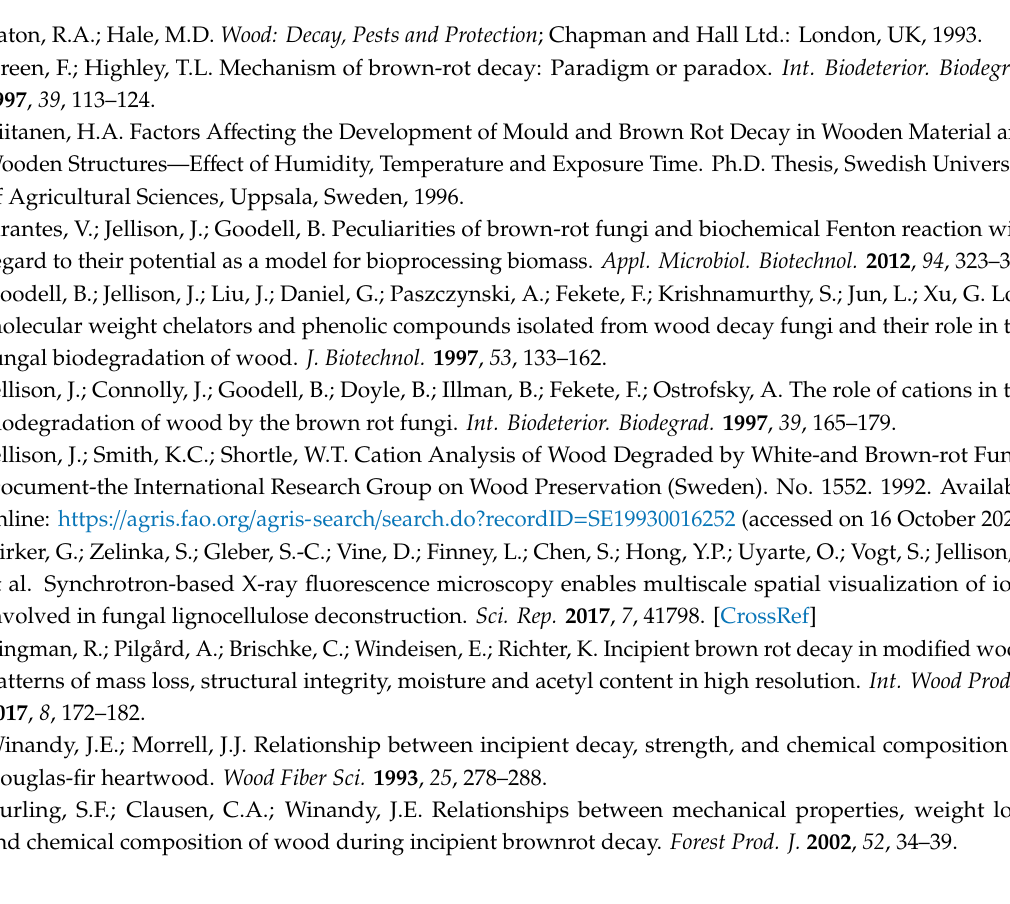
Figure S1: iron_oxalate, Figure S2: